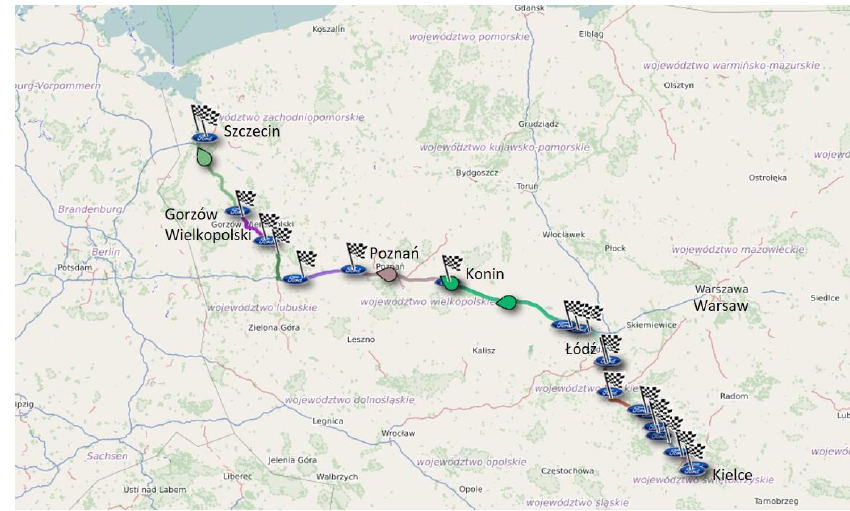
Figure 2. Course of the driven test route according to the Globtrak™